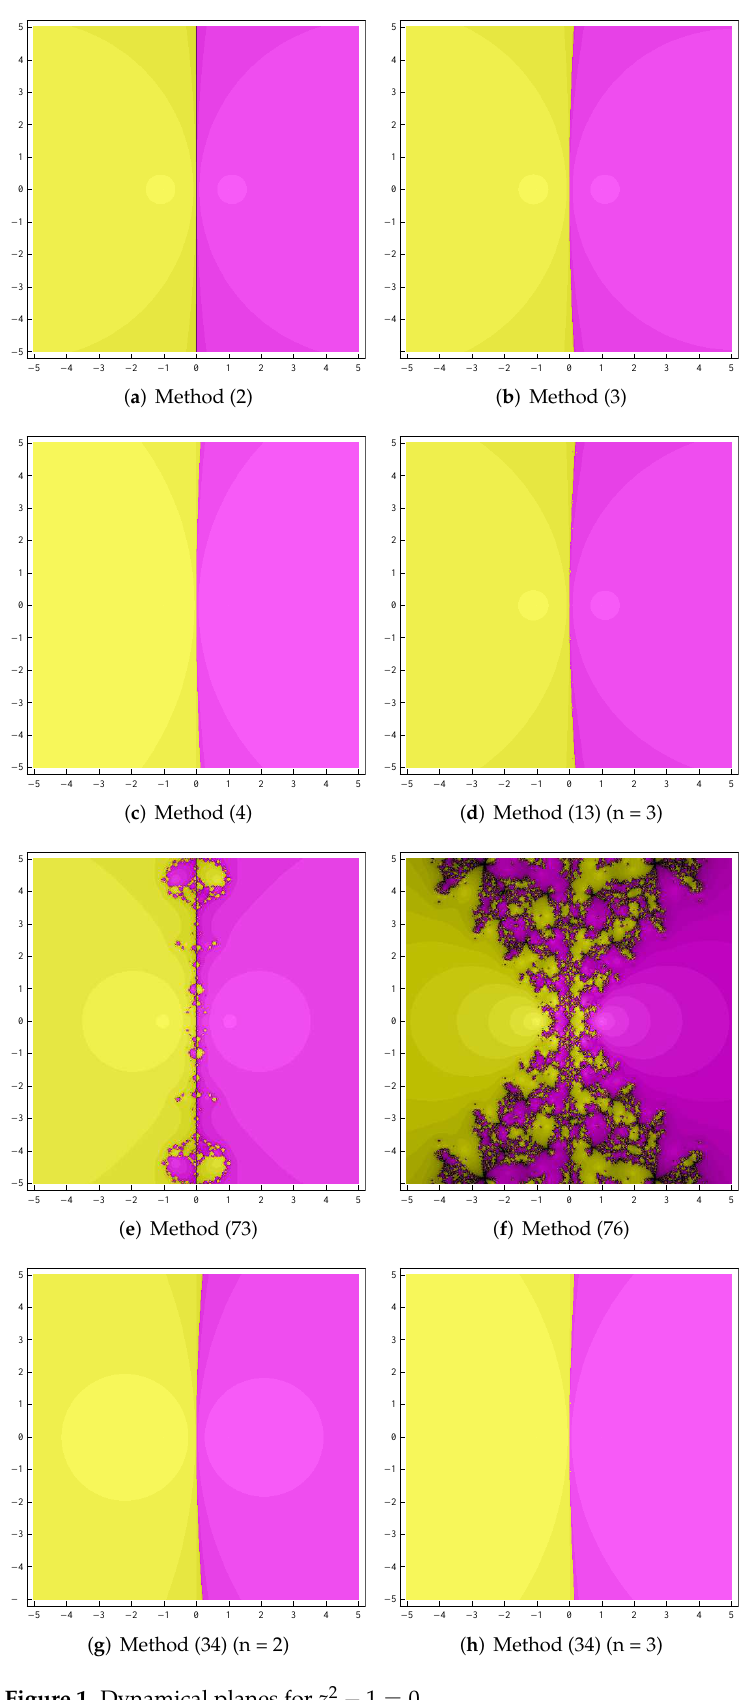
Figure 1. Dynamical planes for z 2 − 1 =